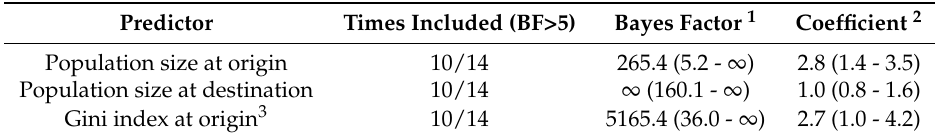
Table 1. Predictors included in over 50% of